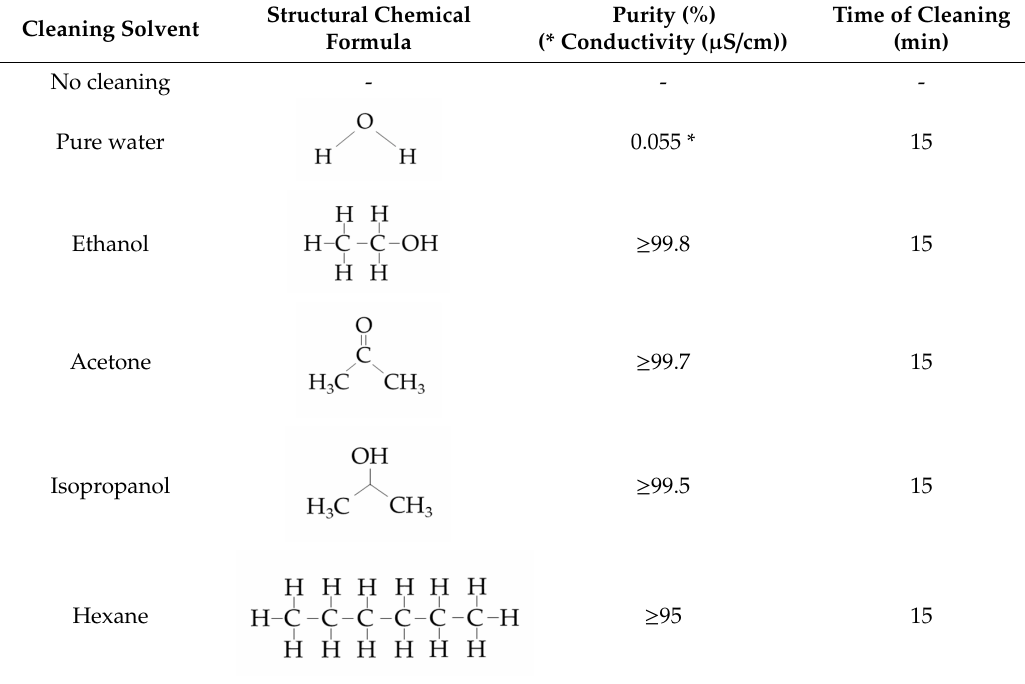
Table 2. Cleaning methods after LT. Used cleaning solvents (Carl Roth GmbH + Co. KG, Karlsruhe, Germany) with structural chemical formula, purity and time of cleaning in ultrasonic bath. For pure water, instead of purity, conductivity is indicated and highlighted by